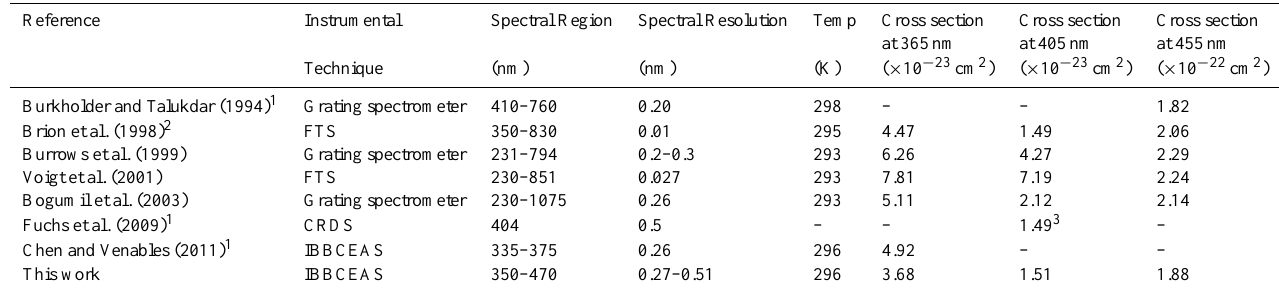
Table 1. Measurements of O 3 absorption cross section between 350–470nm.